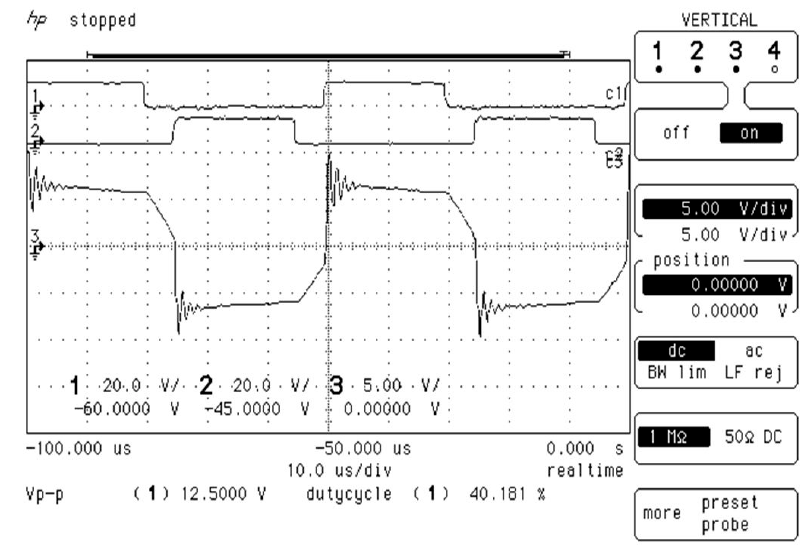
Figure 3. Electrical waveforms obtained in push–pull switched-mode power supply (SMPS), 1, 2—IGBT gate signals, 3—signal obtained in a single turn of secondary coil in no-load.